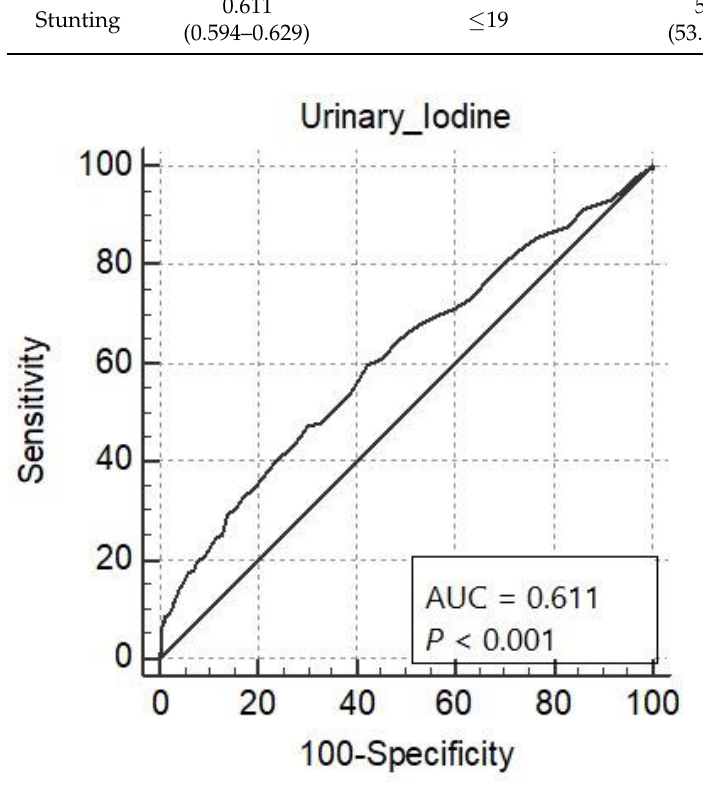
Figure 1. Receiver operating characteristic curve analysis for urinary iodine in µg/L to predict stunting among school children. Table 3. Results of receiver operating characteristics (ROC) for urinary iodine in µg/L to predict stunting among school children.